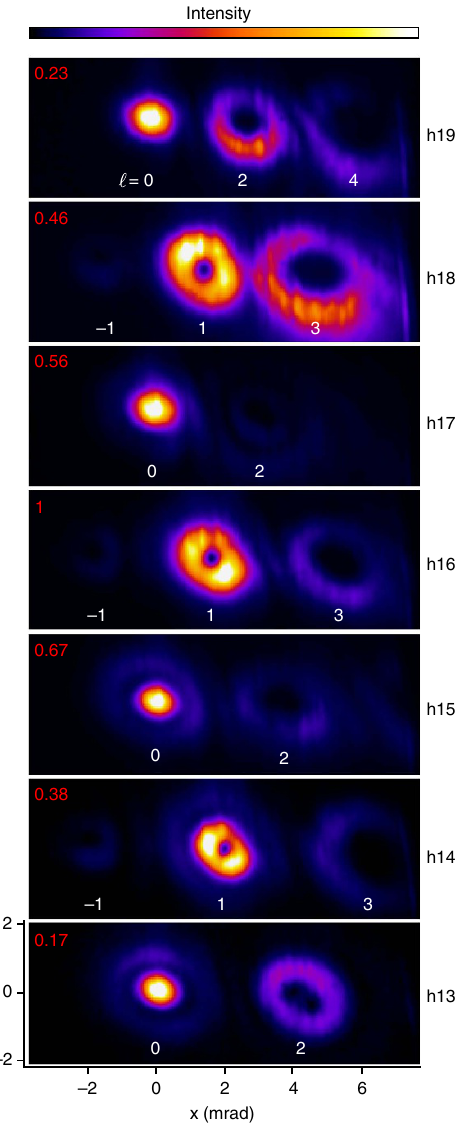
Figure 2 | Far-field intensity patterns from the non-collinear wave-mixing scheme. Single-shot images for different harmonic orders were acquired using a CCD in identical generating conditions. Each mode is labelled by its topological charge c that also corresponds to the number of absorbed 2 o photons. For better visualization, images for each harmonic order are shown with the full colour scale (colour bar on top). The integrated signal (top left corner) is normalized to h16. The number of photons incident on the CCD (after the metallic filter) for h16 was around 7 (cid:3) 10 6 . Note that the angular acceptance of the monochromator (about 10mrad) limited to three the number of modes that could be detected at once.